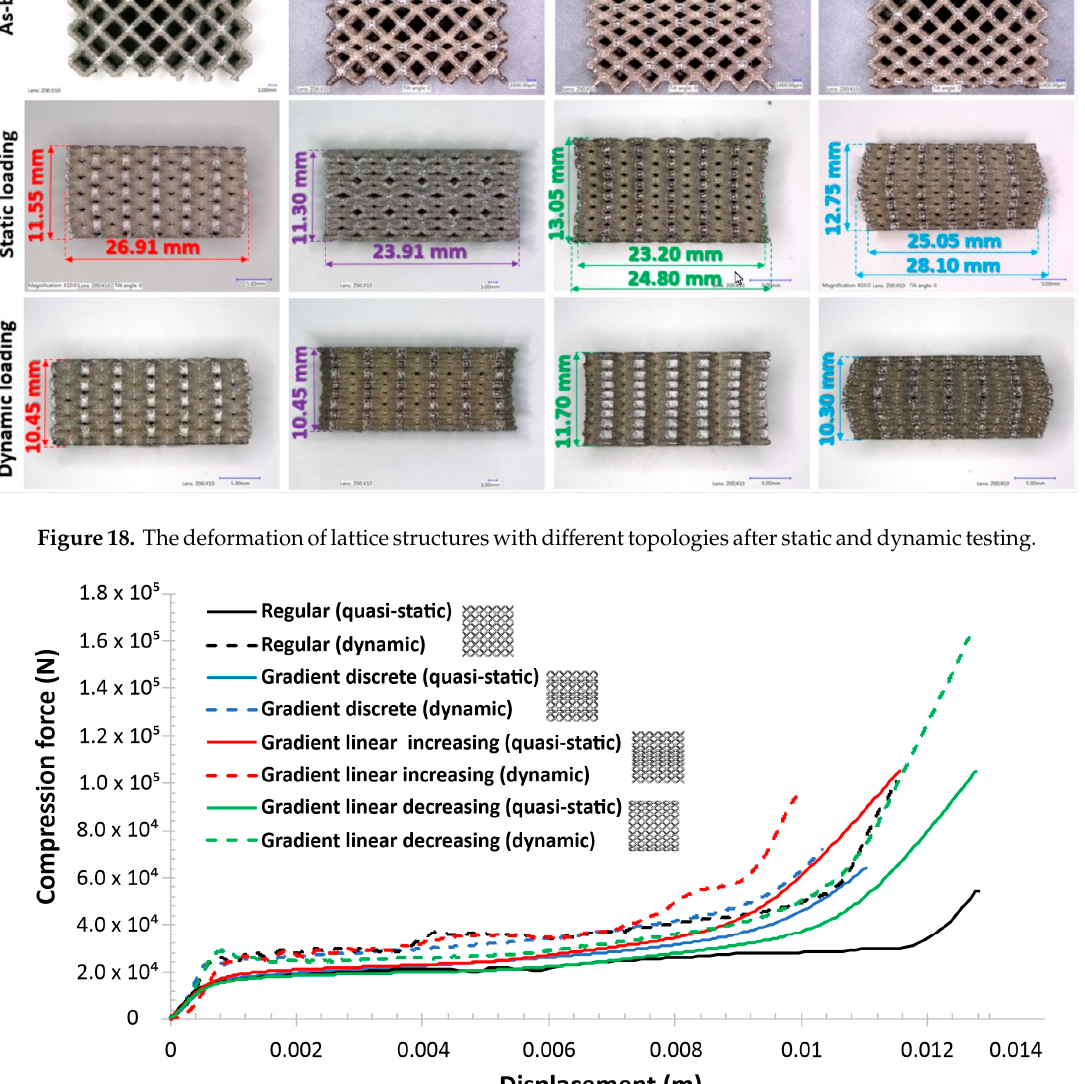
Figure 20. Comparison of deformation energy history plots obtained in quasi-static and impact compression tests.